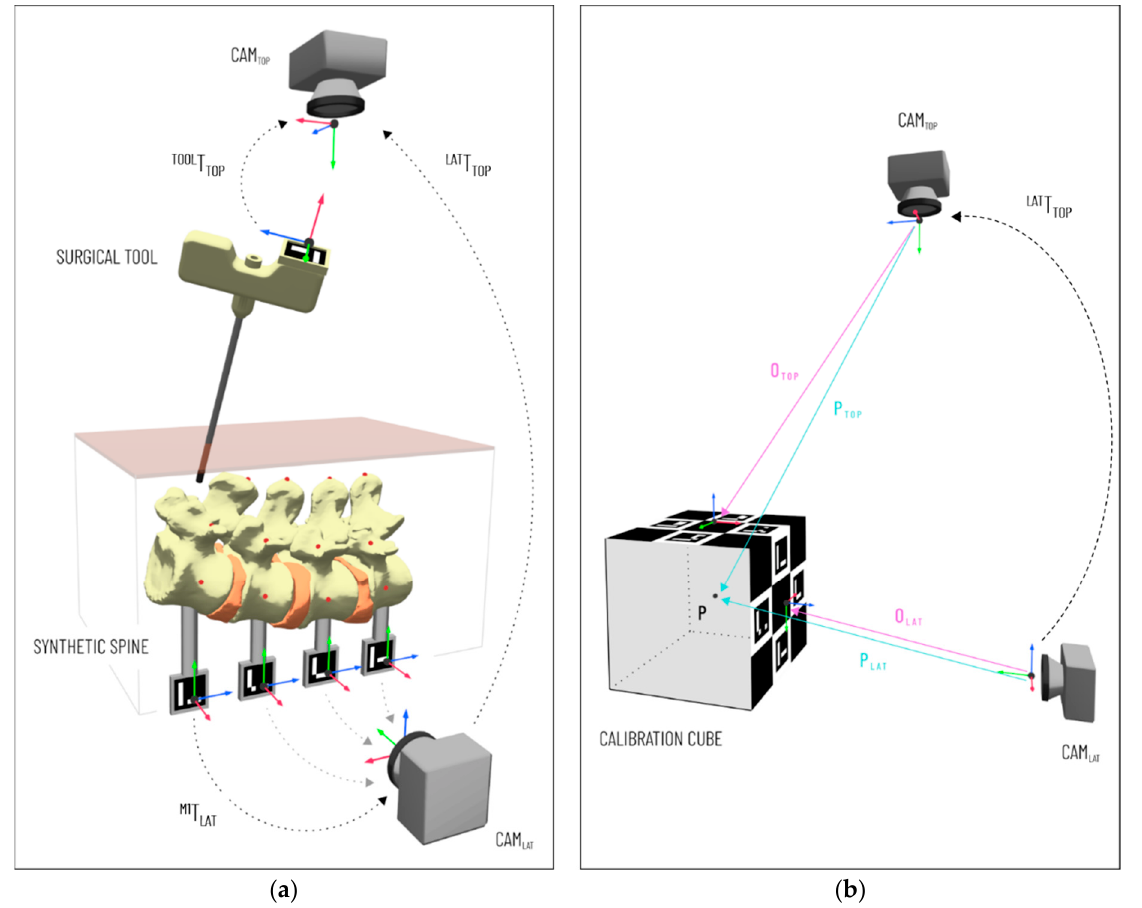
Figure 2. ( a , left ) Cameras and fiducial markers setup with schematic representation of transformation matrix involved. ( b , right ) Calibration of the lateral and top cameras with the calibration cube.